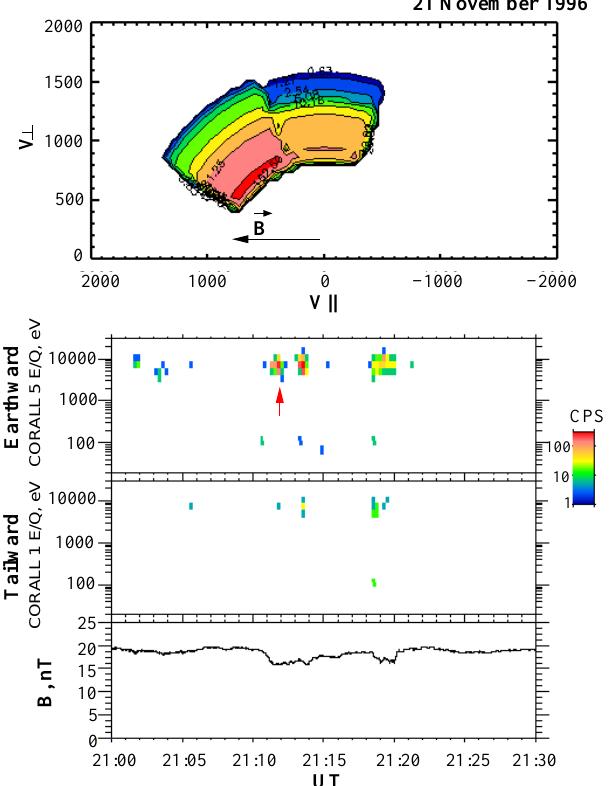
Fig. 2. An example of an isolated beamlet. The lower 3 panels show from top to bottom: E-T spectrogram of earthward ions, E-T spectrogram of tailward ions, the magnitude of the magnetic field. The red arrow marks the beamlet event. The V ⊥ − V || distribution function of the marked beamlet obtained for 3.8s is shown in the top